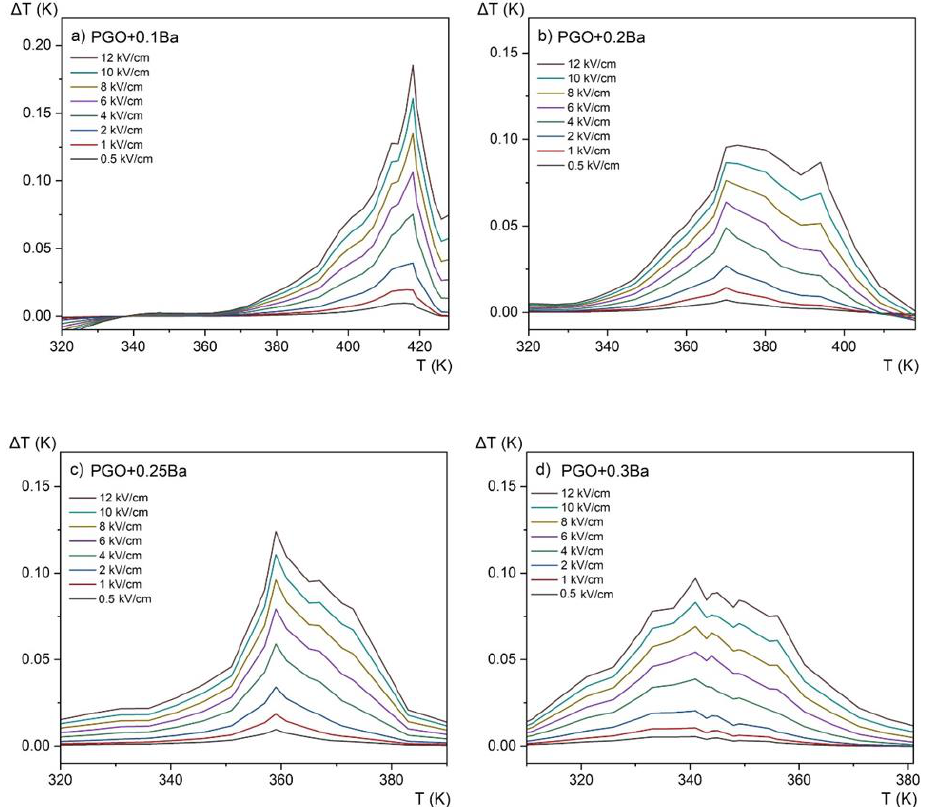
Figure 11. Electrocaloric temperature change ( ∆ T ) as a function of temperature at 0.5–12 kV/cm applied fields for PGO + xBa crystals: ( a ) PGO + 0.1Ba, ( b ) PGO + 0.2Ba, ( c ) PGO + 0.25Ba, ( d ) PGO + 0.3Ba.